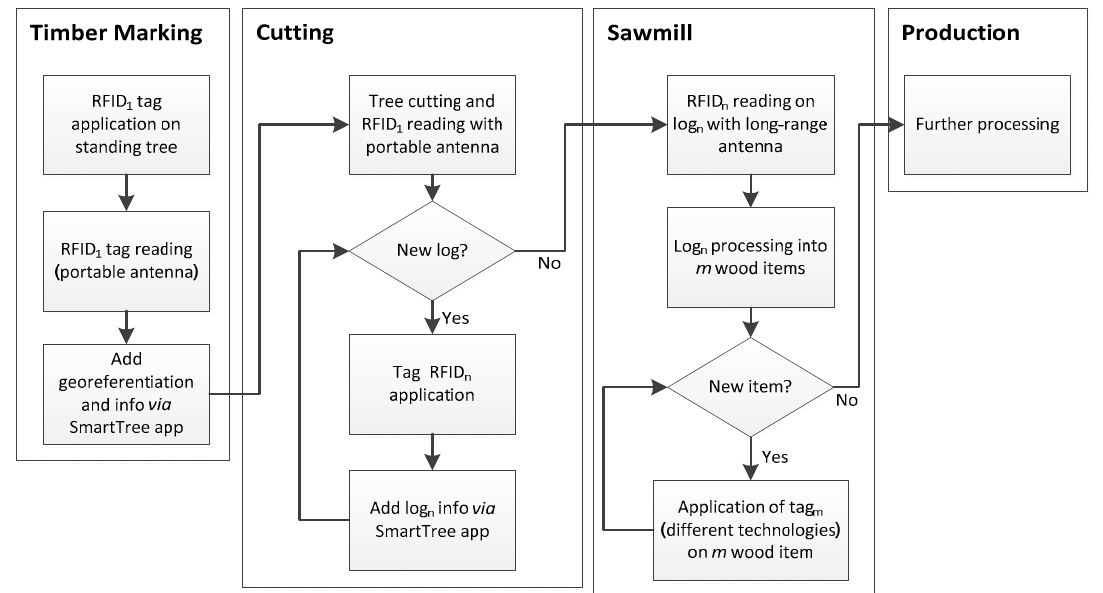
Figure 2. Diagram of the phases in relation to the RFID technologies. In particular of the “timber marking”, “cutting”, “sawmill” and “production” phases.